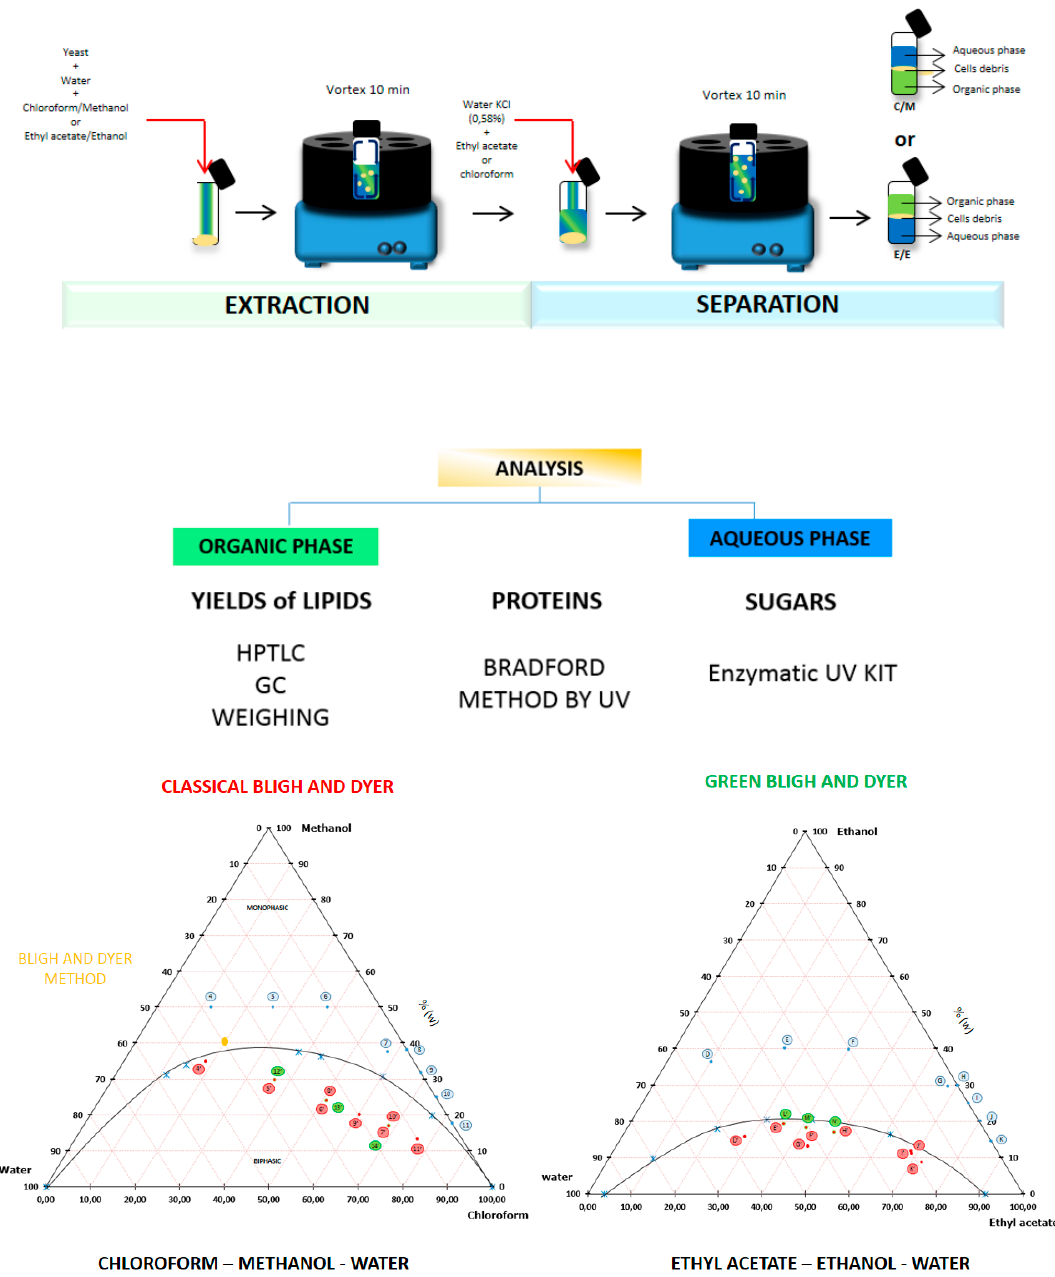
Figure 7. Ternary systems of classical Bligh and Dyer (B &D) (Methanol/Chloroform/Water) and Greener Bligh and Dyer (ethanol–ethyl acetate–water). The black curve separates the monophasic region ( above ) from the diphasic region ( below ).